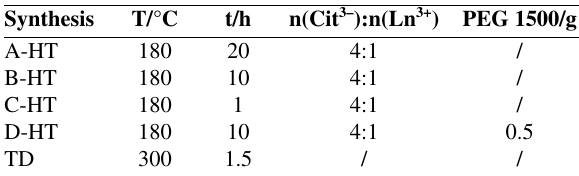
Table 1: UCNPs synthesis